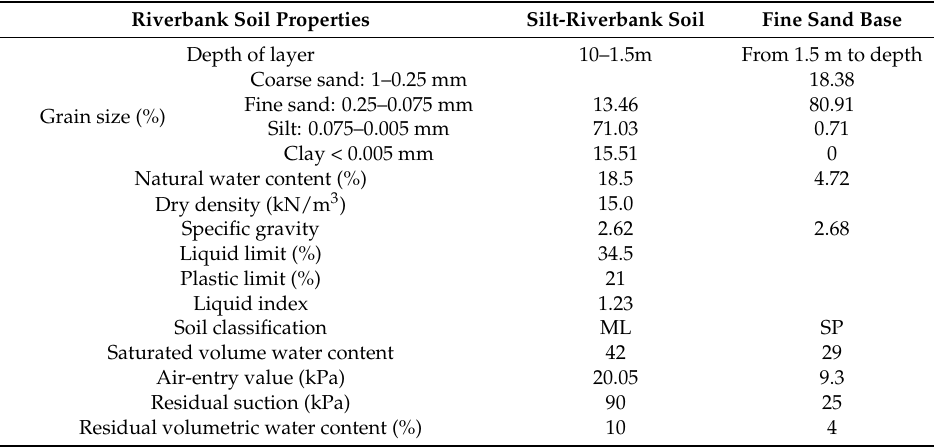
Figure 4. The initial riverbank configuration. The boundary conditions of river water level (RWL) and rainfall intensity were set up in the SEEP/W model. Using the riverbank configuration shown in Figure 4, the initial RWL was the